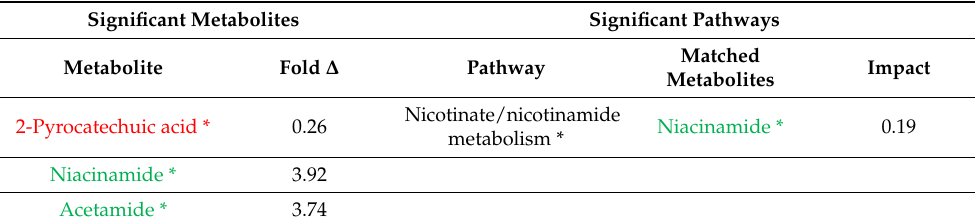
Table 2. Metabolites and their pathways which are different between participants with and without neurodevelopmental regression.